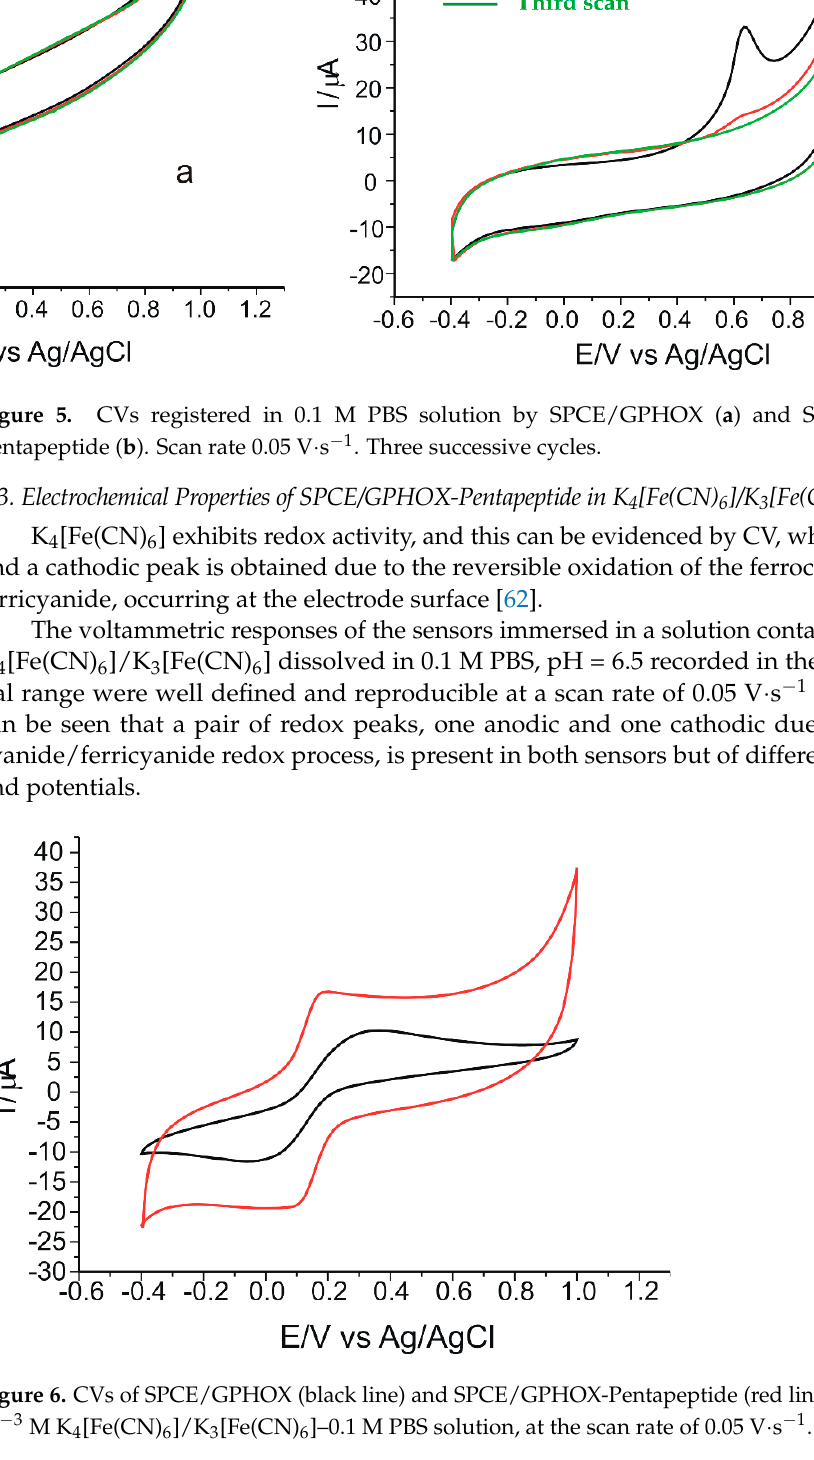
Table 1. The values of the parameters obtained from the CVs of the two sensors immersed in 10 − 3 M K 4 [Fe(CN) 6 ]/K 3 [Fe(CN) 6 ] solution (the electrolyte support was 0.1 M PBS of pH 6.5). Sensor